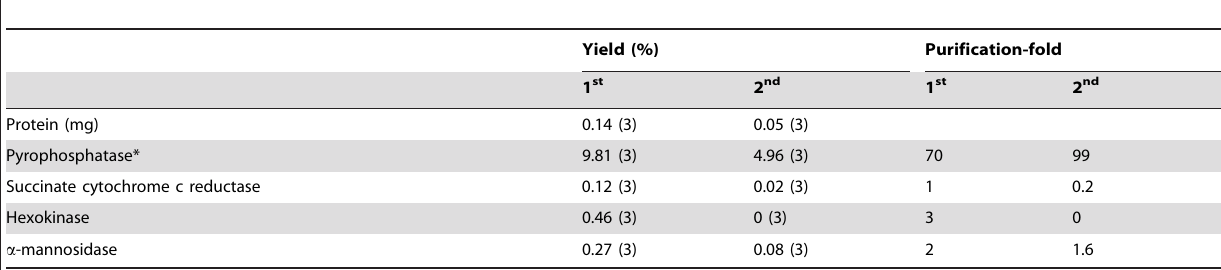
Yield values are percentages relative to the 15,000 6 g pellet fraction and represent averages from number of preparations in parentheses. *Pyrophosphatase activities in the 15,000 g pellet, and the 1 st and 2 nd gradient acidocalcisome preparations were 0.22 6 0.09, 15.6 6 3.2, and 22.6 6 2.1 m mol min 2 1 mg 2 1 protein, respectively (mean 6 SD).